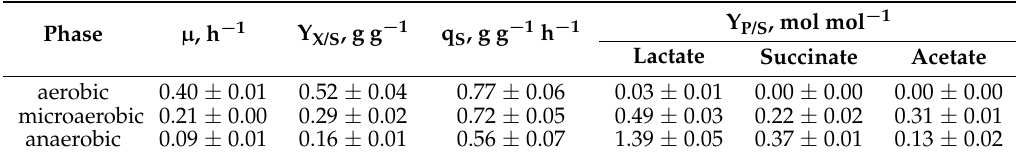
Table 1. Overview of the growth rate ( µ ), the biomass/substrate yield (Y X/S ), biomass specific glucose consumption rate (q S ) and the product/substrate yield (Y P/S ) for the aerobic, microaerobic, and anaerobic condition of triple-phase process (Figure 1A). Errors represent the standard deviation (SD) of four independent experiments.